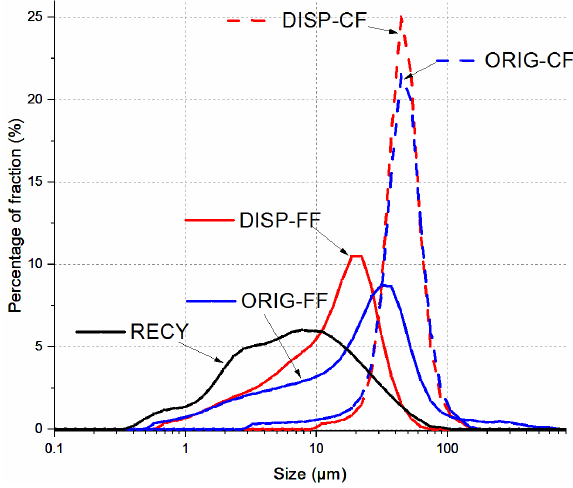
Figure 3: Distribution of particles in the finer and coarse fractions of